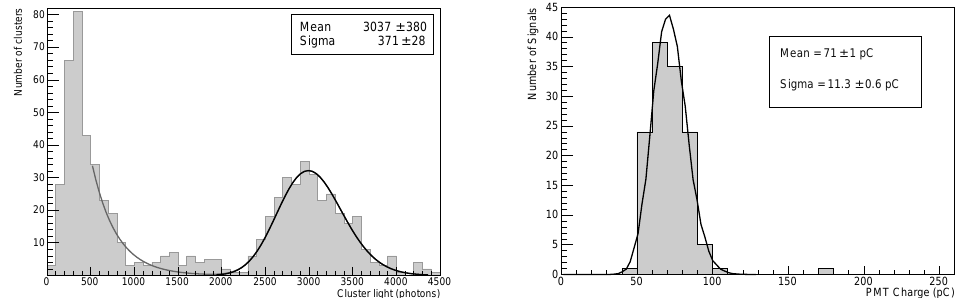
Figure 5. Distribution of the light content of the 55 Fe events reconstructed from the sCMOS images ( left ), and distribution of the charge measured by the PMT signals ( right